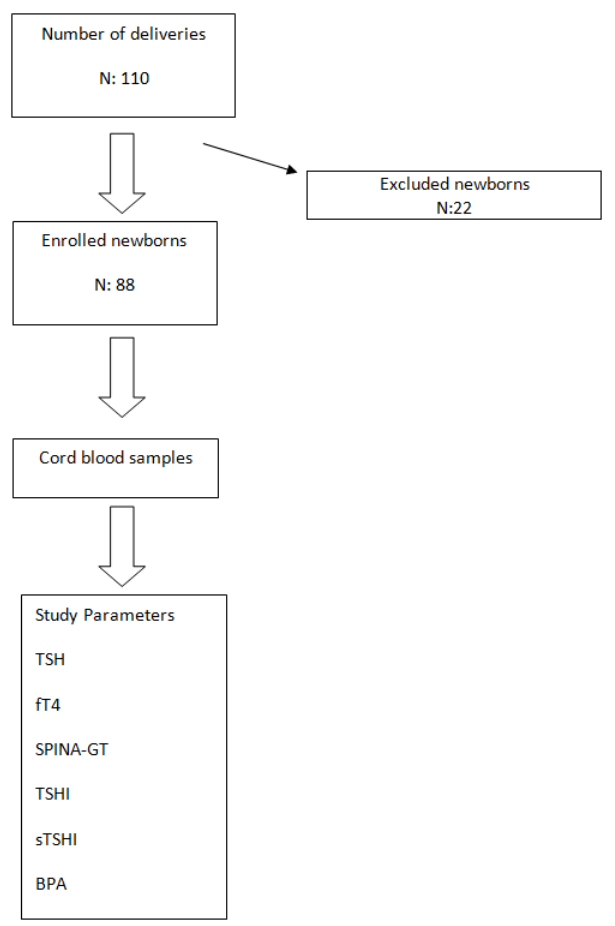
Figure 1. Study Flow Chart.